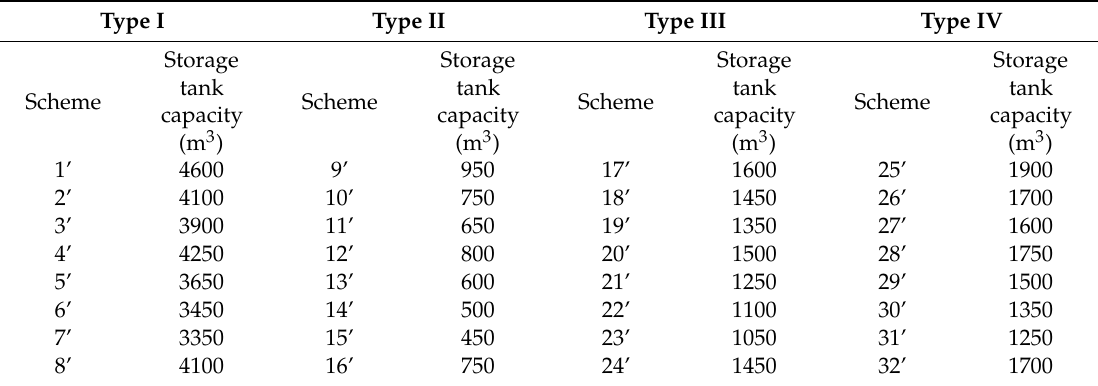
Table 5. Volume of storage tank.